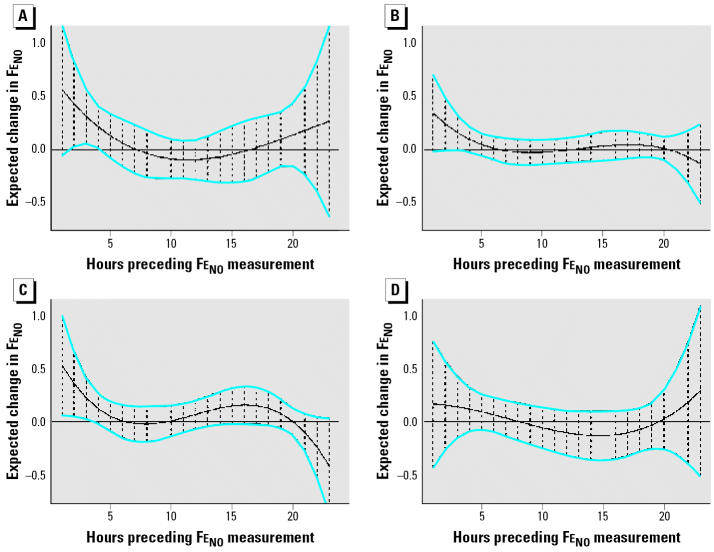
Estimated lag effect of hourly personal PM2.5 on FeNO by use of medications. (A) No anti-inflammatory medications. (B) Anti-inflammatory medications. (C) Inhaled corticosteroids. (D) Antileukotrienes and inhaled corticosteroids. Estimates are based on a 4th-degree linear mixed-effects polynomial distributed lag model with AR(1) correlation structure. Expected changes in FeNO correspond to a 1-IQR (24 μg/m3) change in PM2.5. Blue bands indicate pointwise 95% CIs. Vertical dashes represent hourly measurements. All estimates are adjusted for personal temperature and relative humidity.